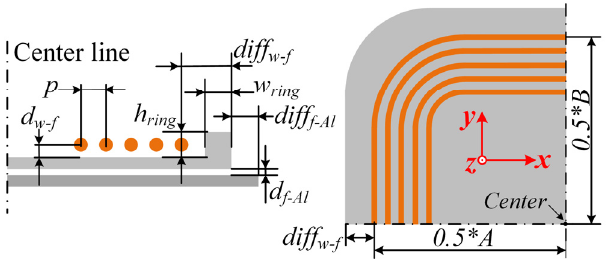
Figure 4. Geometric parameters of the coil assembly (quarter model).